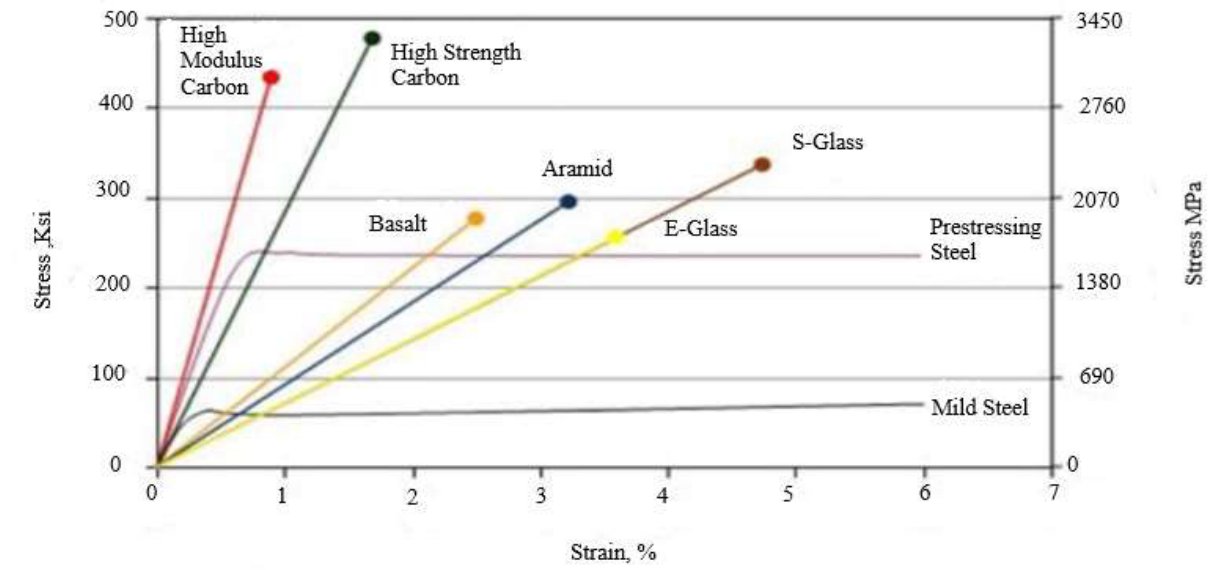
Figure 2: comparison of stress-strain relationships between FRP composites and reinforcing steel